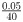
Response probabilities (RPs) and selectivity.(A) RPs (see Calculation of response probabilities section in Materials and methods) in percent across different categories and anatomical regions. Error bars indicate 95% CIs estimated by a subsampling procedure (see Calculation of response probabilities section in Materials and methods). Asterisks on top of a bar indicate a significant deviation of RP from RP of all other categories in a region (Fisher’s exact test, Bonferroni-corrected α = 0.0540). (B) Overview of SUs and MUs and their responsiveness to at least one of the stimuli. (C) Cumulative distributions of neuronal response selectivity, that is, the number of response-eliciting images identified per unit, truncated after 35 on the x-axis. Data and scripts underlying this figure are deposited here: https://github.com/rebrowski/abstractRepresentationsInMTL. AM, amygdala; CI, confidence interval; EC, entorhinal cortex; HC, hippocampus; MU, multiunit; nr, nonresponding; PHC, parahippocampal cortex; r, responding; RP, response probability; SU, single unit.